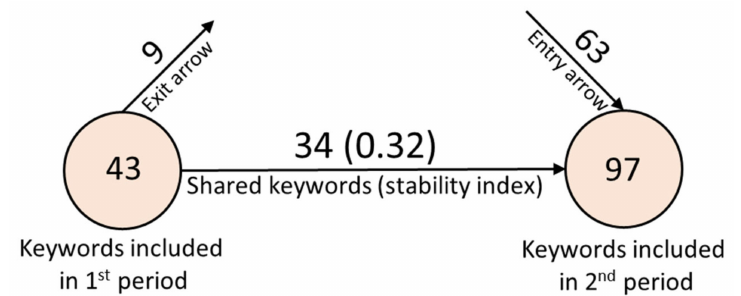
Figure 2. Overlay